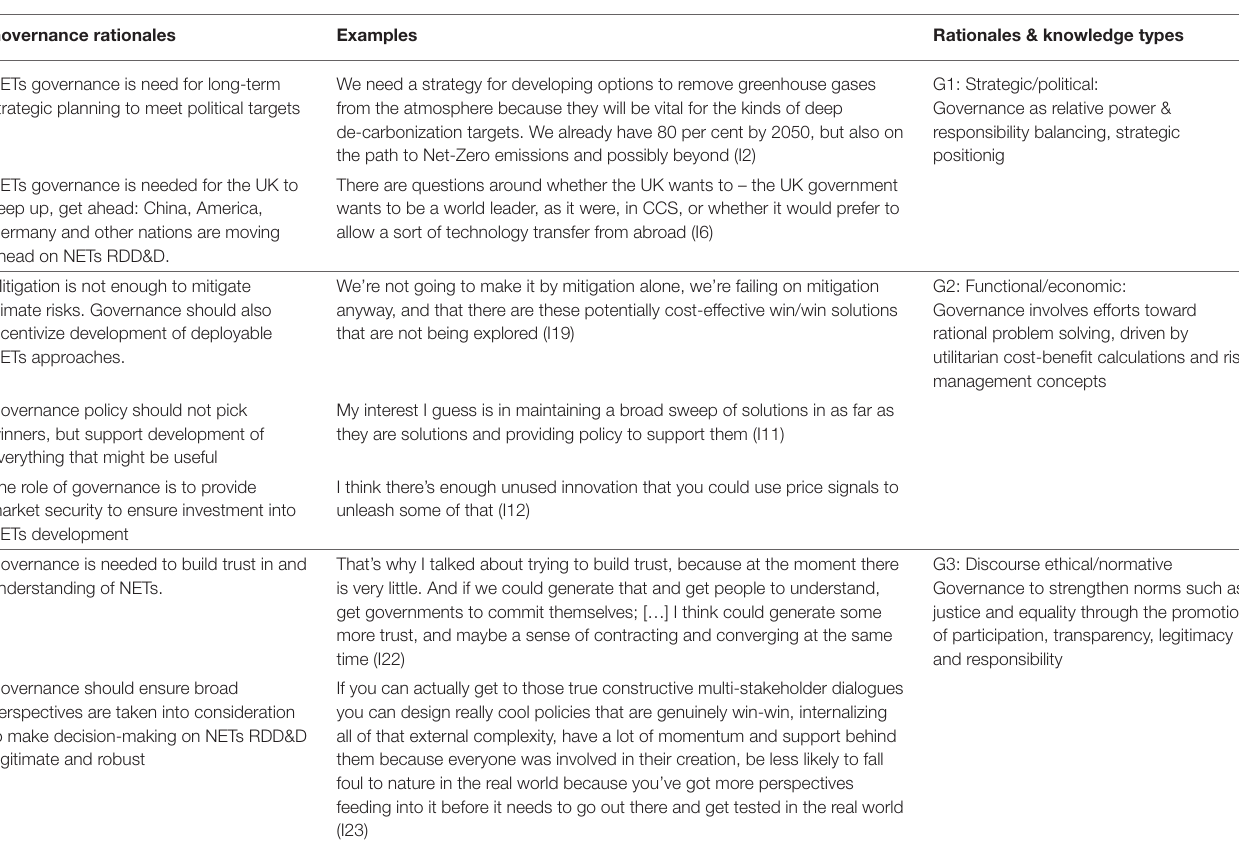
TABLE 2 | Rationales and knowledge types structing calls for